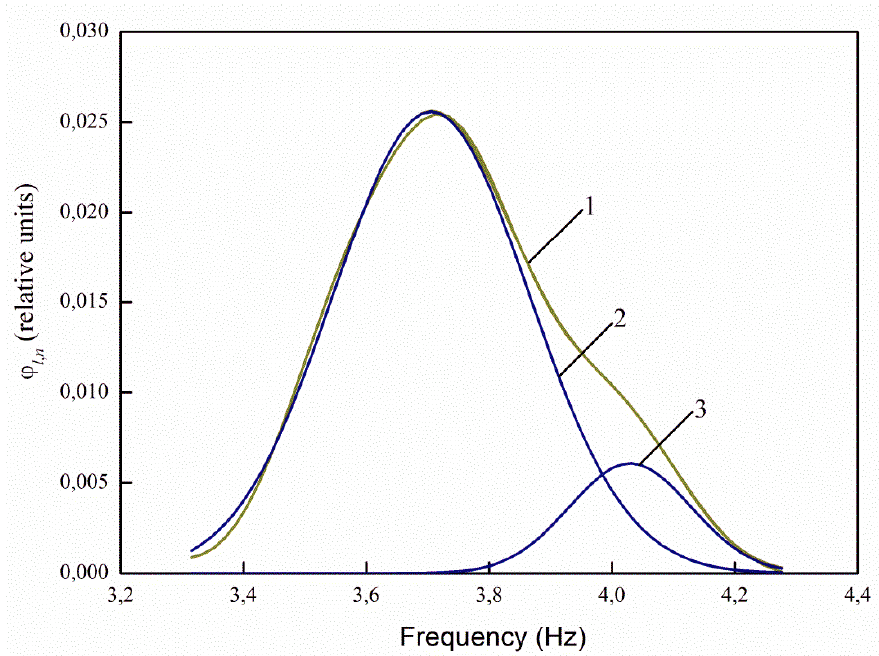
Figure 8. The spectral characteristic of the luminescence of uninfected replacements of wheat at λ e, 1 = 232 nm (1), decomposition by Gaussian curves (2) and (3), where φ l,n is the normalized photoluminescence intensity.